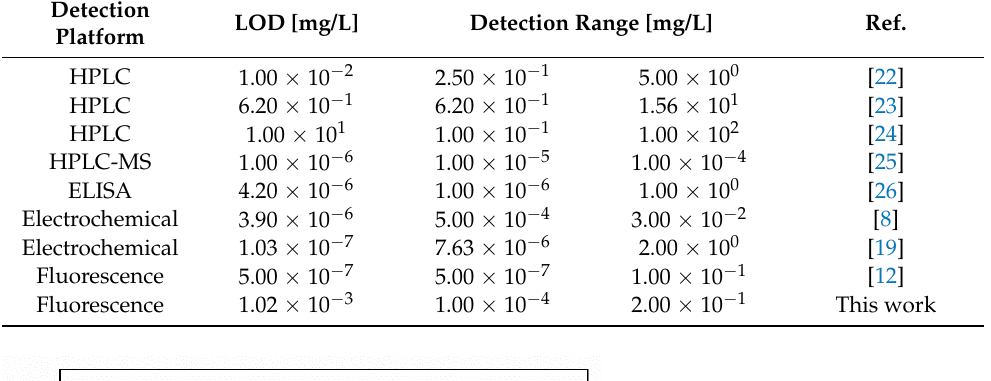
Table 2. Comparison of LOD Obtained from the Reaction with those of Previously Reported Methods. Detection